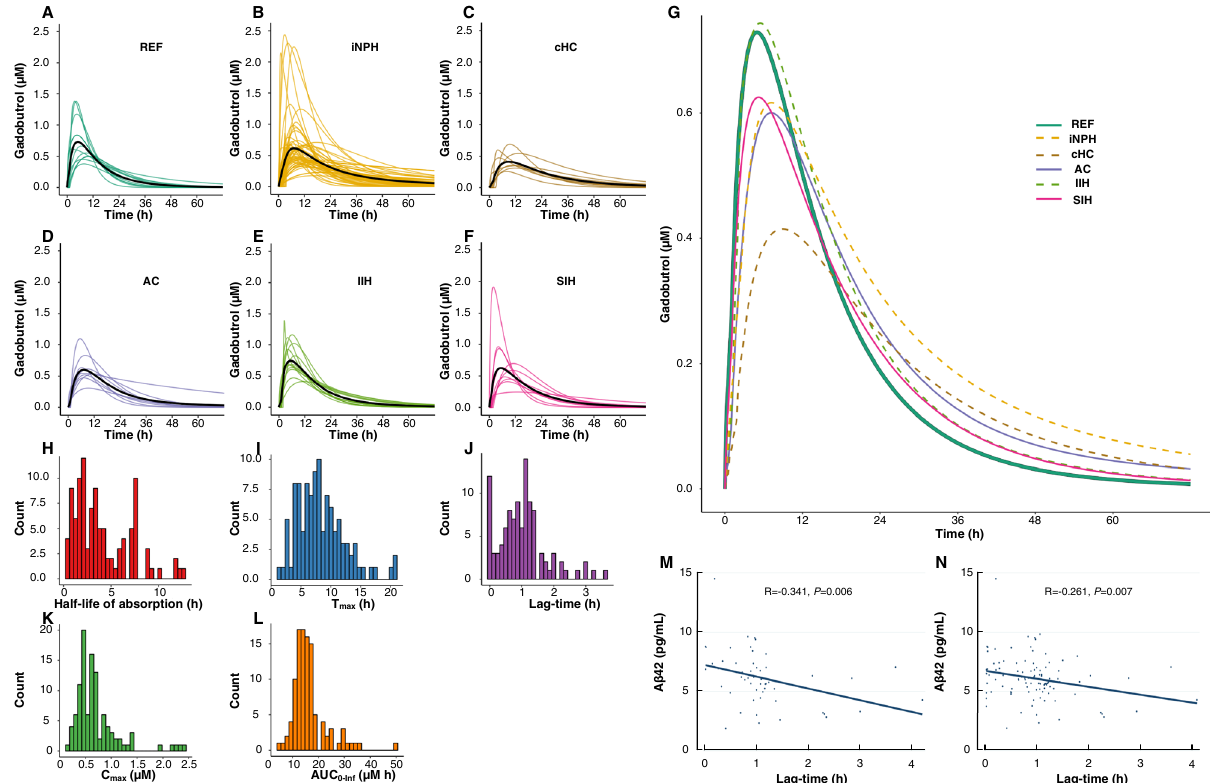
Fig. 3 | CSF-to-blood clearance. Inter-individual variability in CSF-to-blood clear- ance for the diagnosis categories shown for the A reference (REF), B idiopathic normal pressure hydrocephalus (iNPH), C communicating hydrocephalus (cHC), D arachnoid cyst (AC), E idiopathic intracranial hypertension (IIH), and F spontaneous intracranial hypotension group. The curves show individual pos- terior dose-normalizedpredicted concentrations of gadobutrol over time, and the black lines signify the mean concentration for each group, averaged at each time point. G The individualposteriorpredicteddose-normalizedblood concentrations ofintrathecalgadobutrolfromthepopulationpharmacokineticmodel,averagedat each time point by group, illustrates differences between groups. The distribution